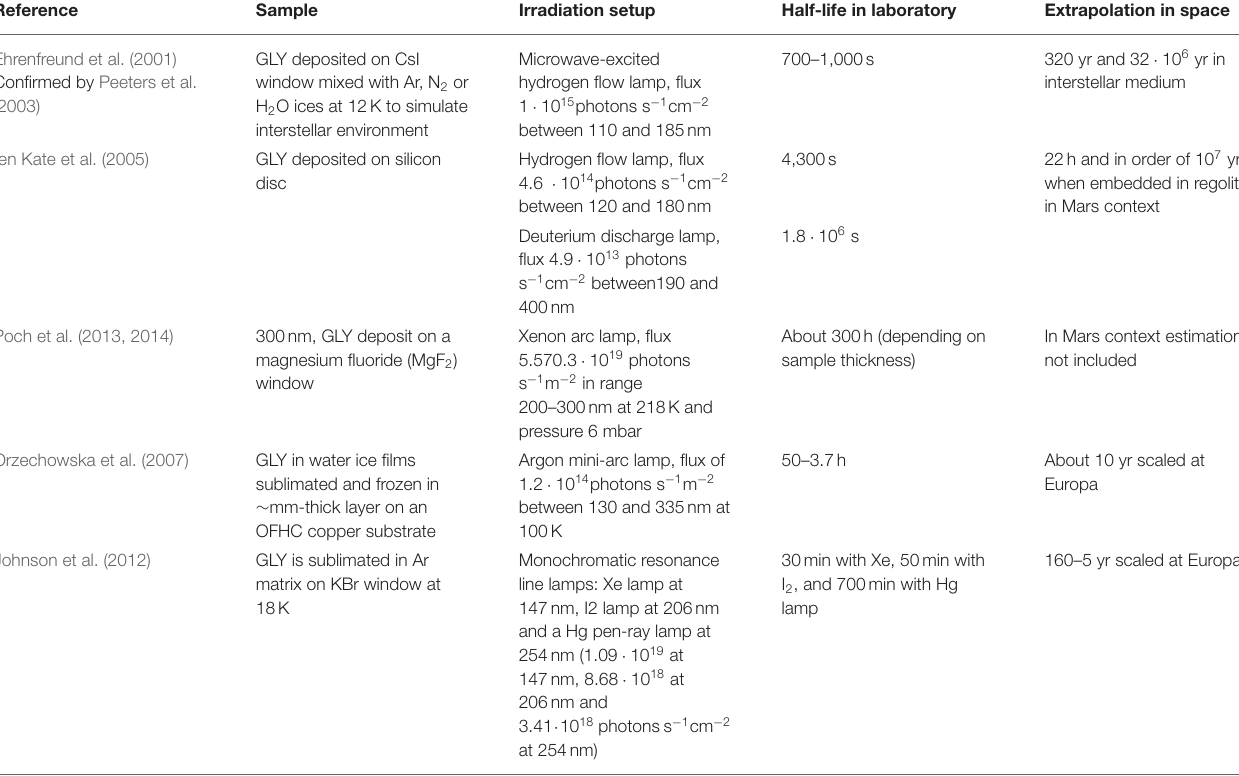
TABLE 1 | Recap on literature irradiation experiments with GLY deposited on windows.